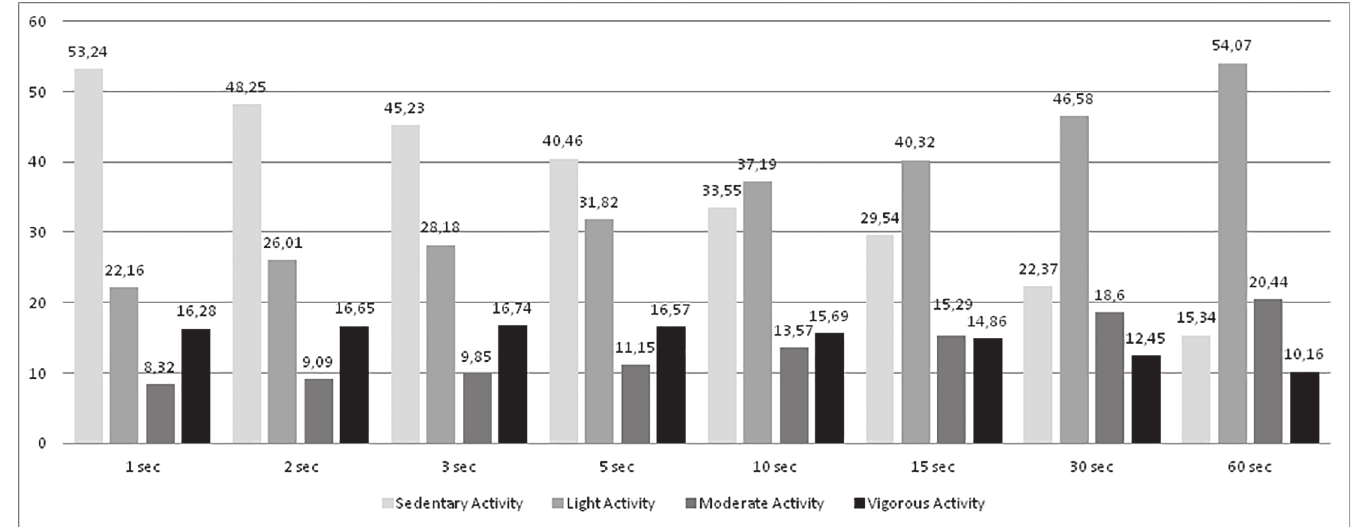
Fig 1. Percentages of sedentary, light, moderate and vigorous physical activity by epoch length for all PE lessons.